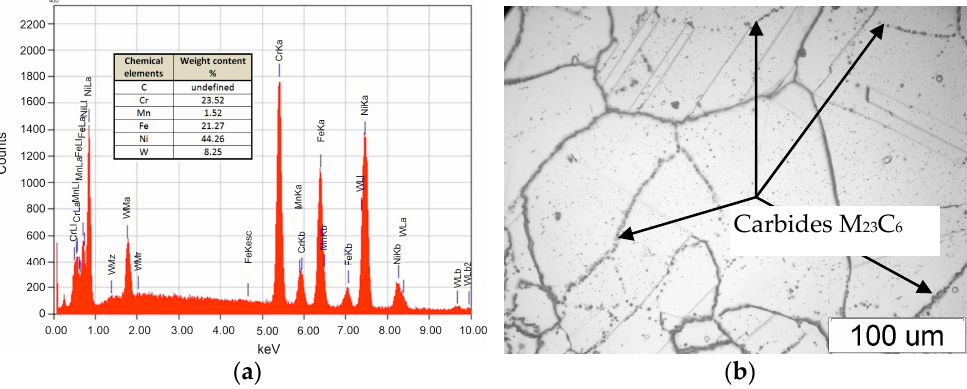
Figure 1. SEM. X-ray energy spectrum of the as-delivered HR6W ( a ); microstructure of the as-delivered HR6W alloy ( b ).